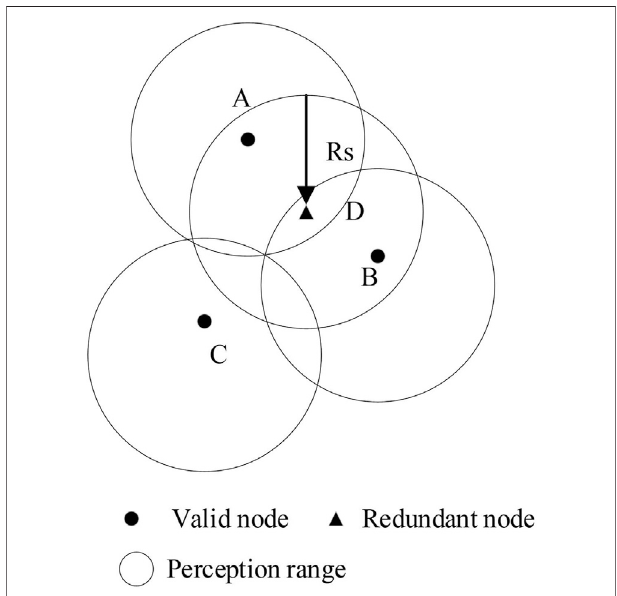
FIGURE 3 | Redundant nodes in the radiation detection and monitoring system.